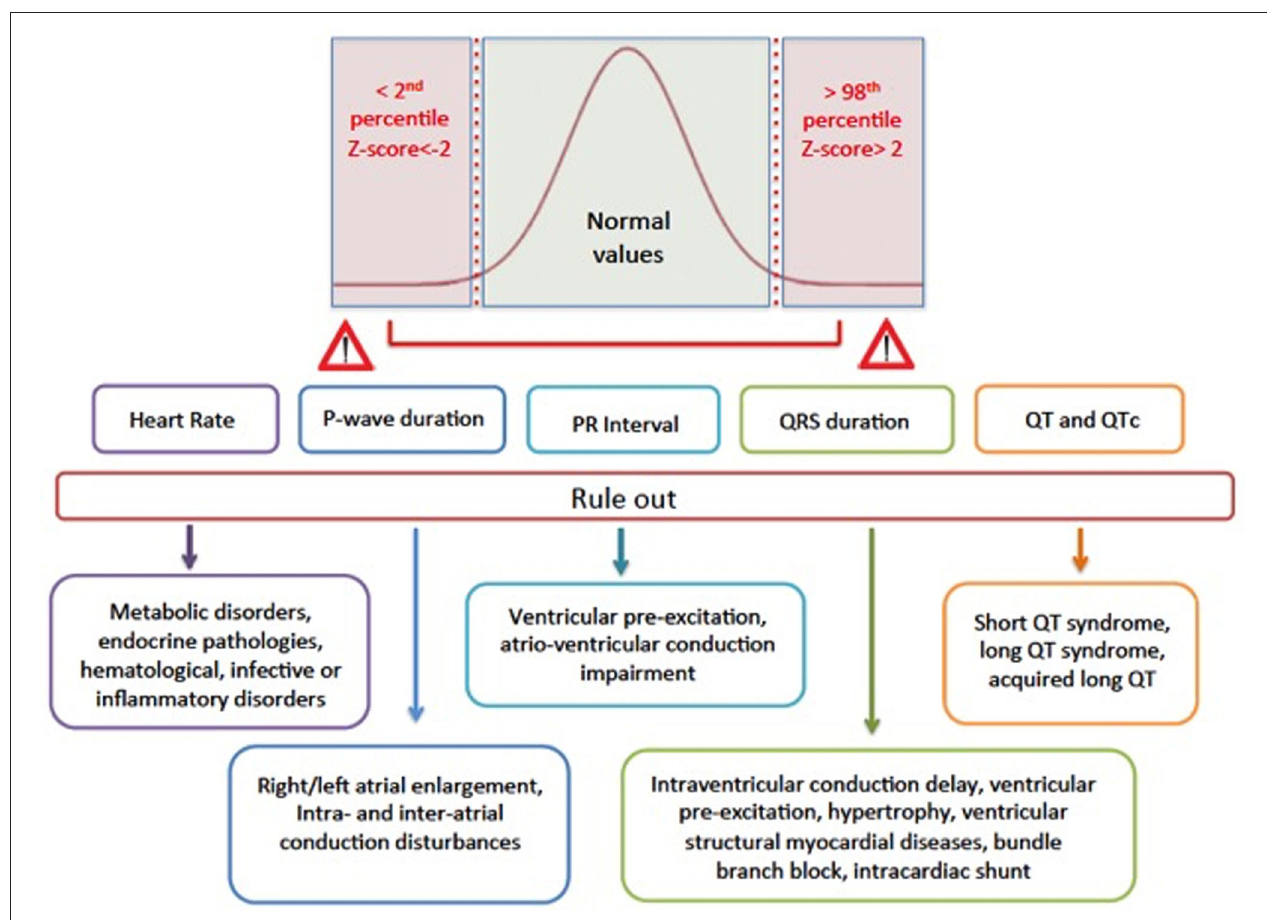
FIGURE 3 | Graphical representation of why reference values are important in clinical practice. Values < 2nd or > 98th percentiles correspond to Z − scores of < -2 or > 2, respectively, and they may imply the presence of a specific pathology or disease that should be ruled out because that value is outside the normal values, present in the 96% of the study